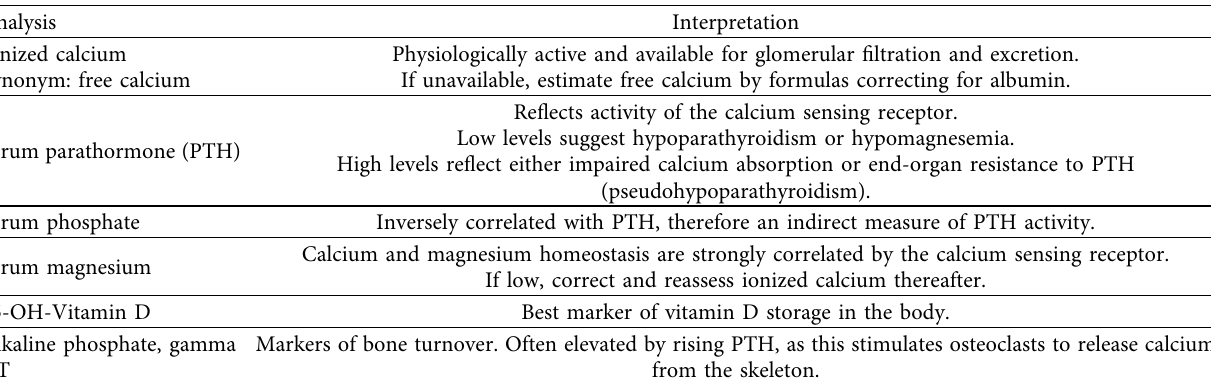
Table 3: Investigations in a child with hypocalcemia [7, 9].